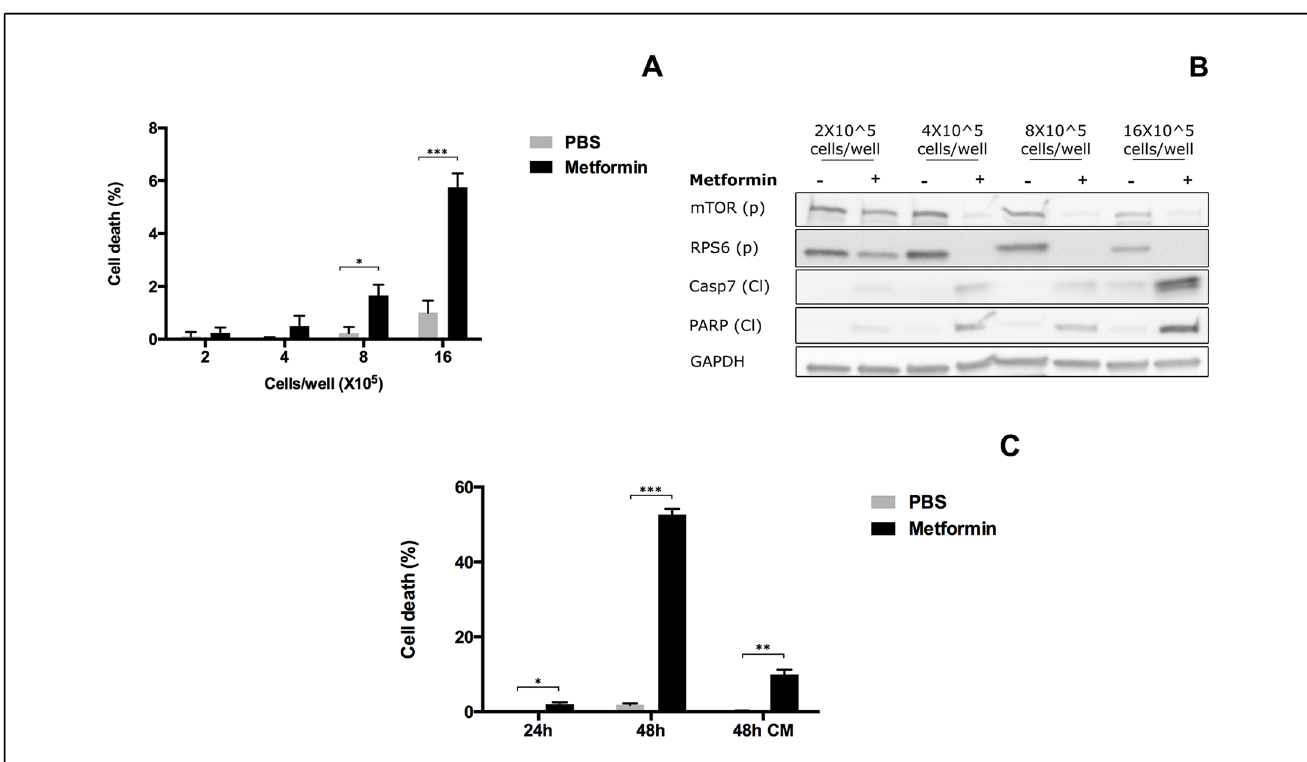
Fig 1. Cell density and nutrient availability influence metformin effect on mTOR pathway and apoptosis. MCF7 cells were plated in MEM medium at different densities from 2X10 5 to 16X10 5 cell/well in 6-well plates. Cells were then treated with 10mM metformin or with PBS as control for 24 hours. A ) After treatment cells were collected and counted with Trypan Blue dye to discriminate between dead and alive cells. Results are reported as percentage of dead cells on the number of total cells. The bars represent the mean of three independent experiments. B ) Cells were collected after 24 hours treatment and protein extracts were subjected to Western Blot analysis to determine the level of phosphorylation of mTOR (p) Ser2448 and RPS6 (p) Ser240/244. We also monitored the levels of cleaved Caspase7 (Cl) and PARP (Cl). GAPDH was used as loading control. The blot is representative of three independent biological replicates. C ) MCF7 cells were plated in MEM medium at a density of 8X10 5 cells/well and treated with 10 mM metformin or with PBS for 24h, 48h or 48h changing the medium after the first 24h treatment (48h CM). Cells were collected after treatment and counted with Trypan Blue dye to discriminate dead from alive cells. Results are reported as percentage of dead cells over the total number of cells. The bars represent the mean of three independent experiments.